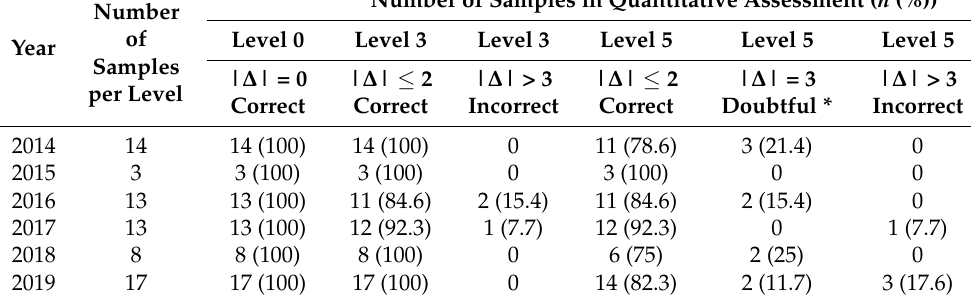
Table 5. Quantitative assessment.